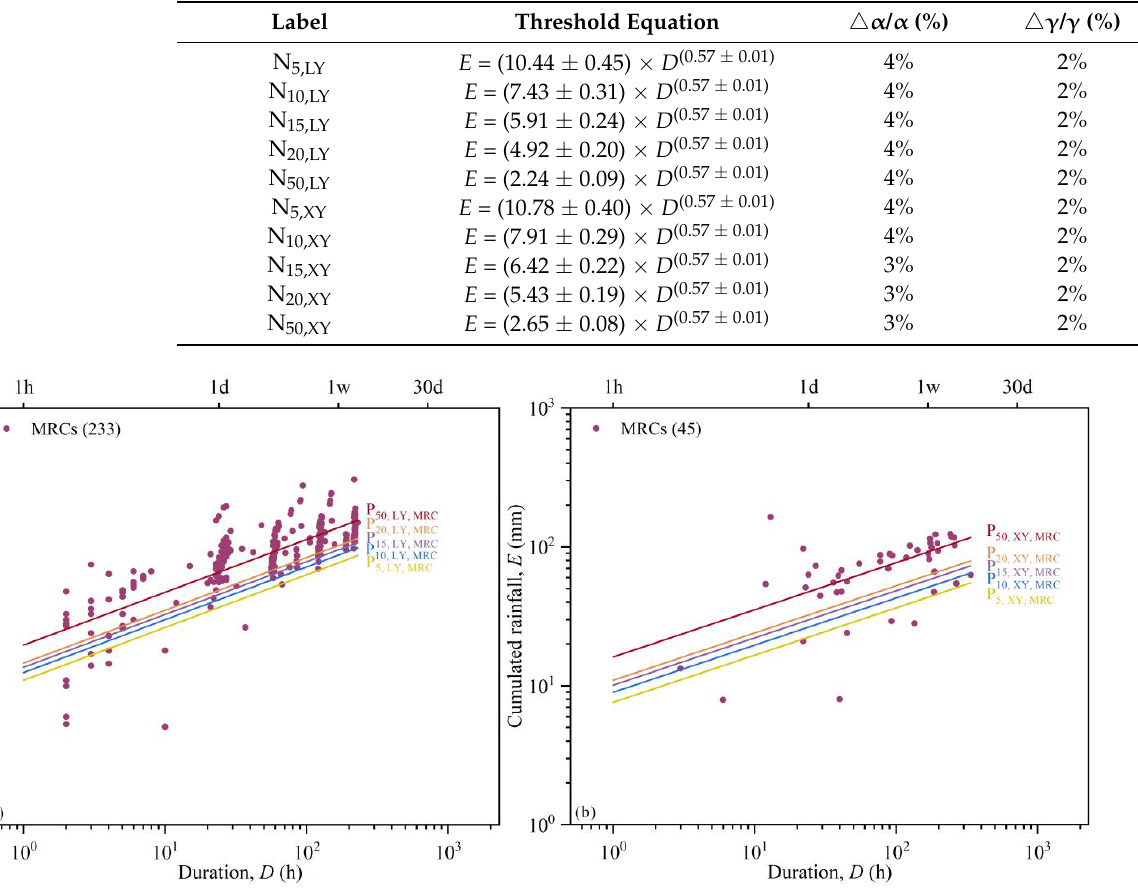
Figure 6. Defined positive rainfall thresholds based on MRC: ( a ) LY county; ( b ) XY county.